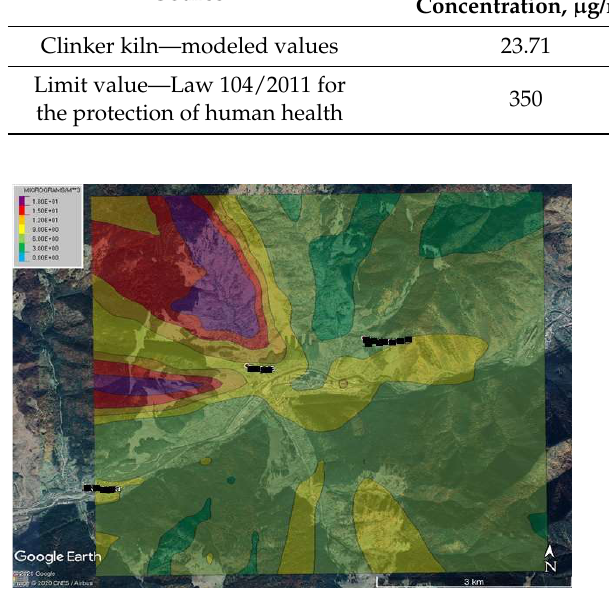
Table 11. Maximum SO 2 concentrations extracted from modeling (hourly and daily).